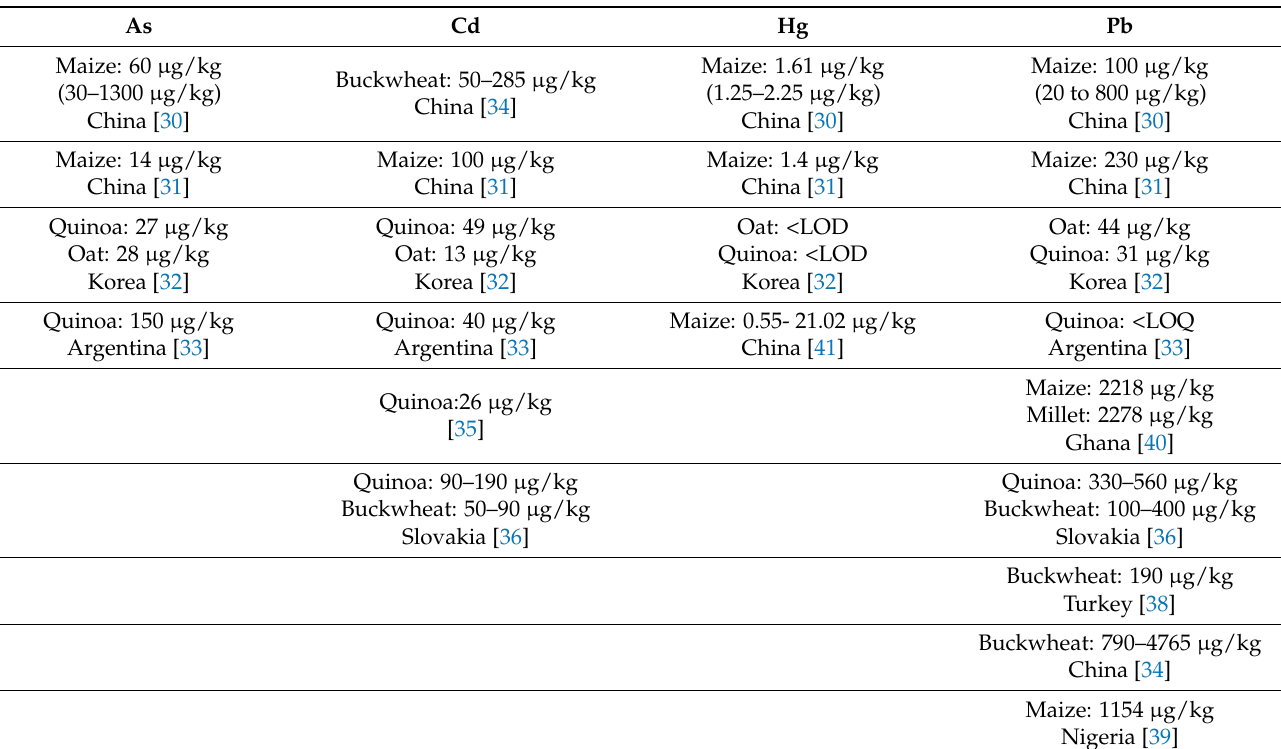
Table 9. Results obtained by other